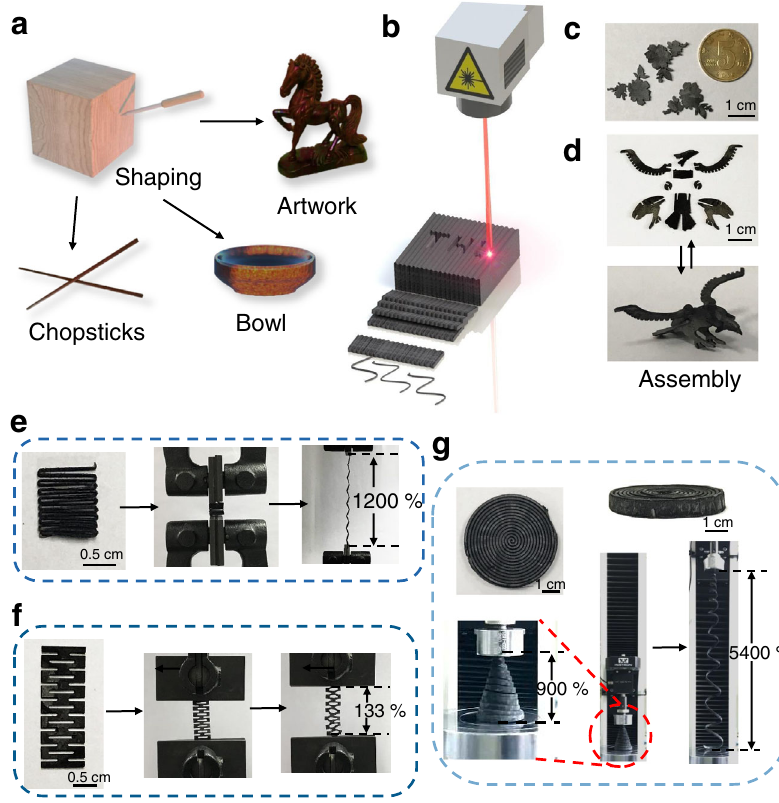
Fig. 1 | Traditional engraving and laser-engraving for graphene aerogels (GAs) with arbitrary geometries. a Schematic illustration of traditional engraving for tools and artwork, such as a pair of chopsticks, a bowl, and a sculpture of steed. b Schematicillustrationoflaser-engravingonGAwitharbitraryshapes. c Thepeony fl ower pattern of GAs with fi ne structures as small as a fi fty cents coin after laser-